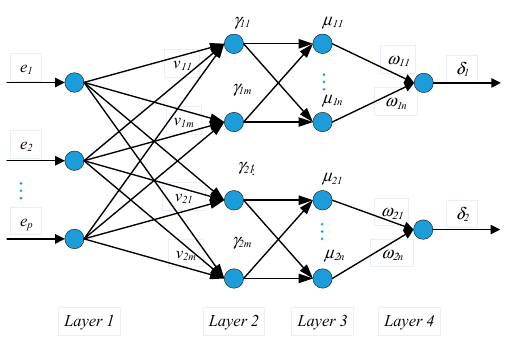
Figure 5. Structure of the radial basis function neural network (RBFNN).